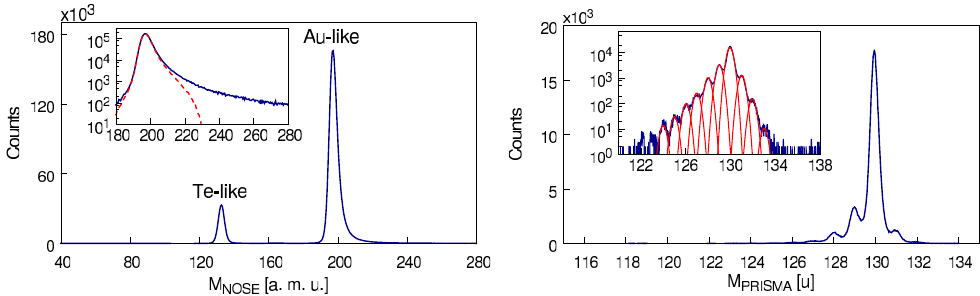
Figure 4. (left) Mass spectrum obtained employing the NOSE detector. The inset shows the mass distribution of Au-like events in logarithmic scale, with red-dashed curve with the coincidence of Te-like ions detected in PRISMA. (right) Mass distribution for the Te isotopes obtained after ion trajectory reconstruction in PRISMA. The inset shows the distribution in logarithmic scale with the multi-Gaussian fit used to evaluate the yields of the neutron transfer channels.